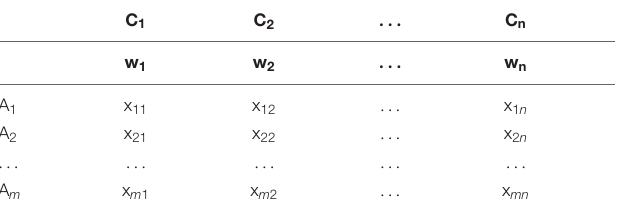
TABLE 1 | Decision matrix of an MCDM problem characterized by m alternatives (A i ) and n criteria (C j ), associated with a weight w j